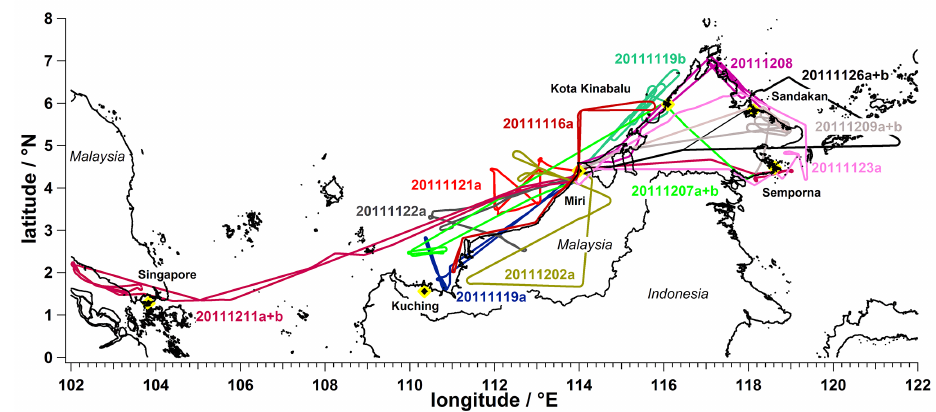
Figure 1. Overview over the different flight tracks of the Falcon during SHIVA. The colour coding indicate the different flights and the corresponding numbering is the date of the flight in the format year (YYYY), month (MM), day (DD) and a letter, whether it is the first (a) or the second (b) flight of a